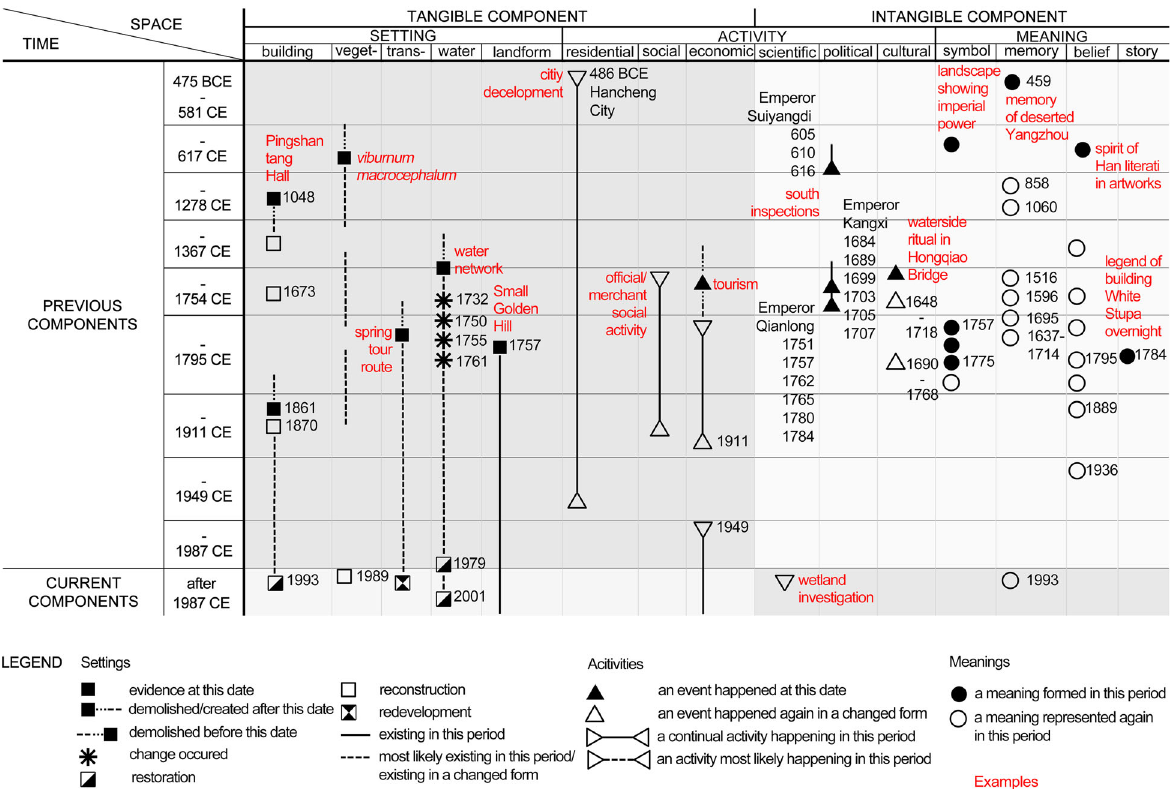
Fig. 4 The four-dimensional model of Slender West Lake for geo-database design (Source: the